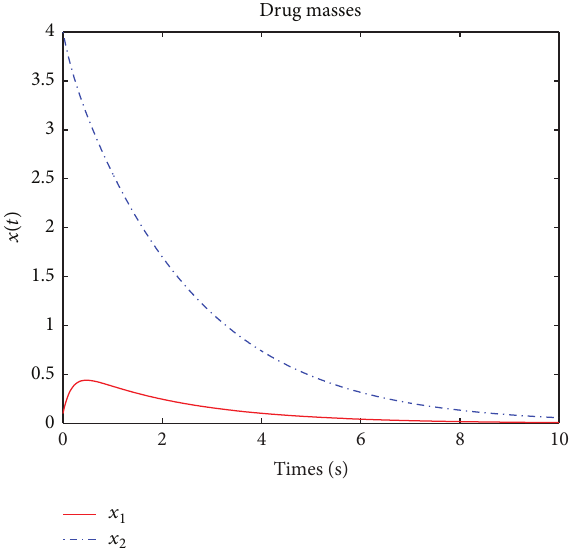
Figure 2: Time response of the controlled biochemical network.